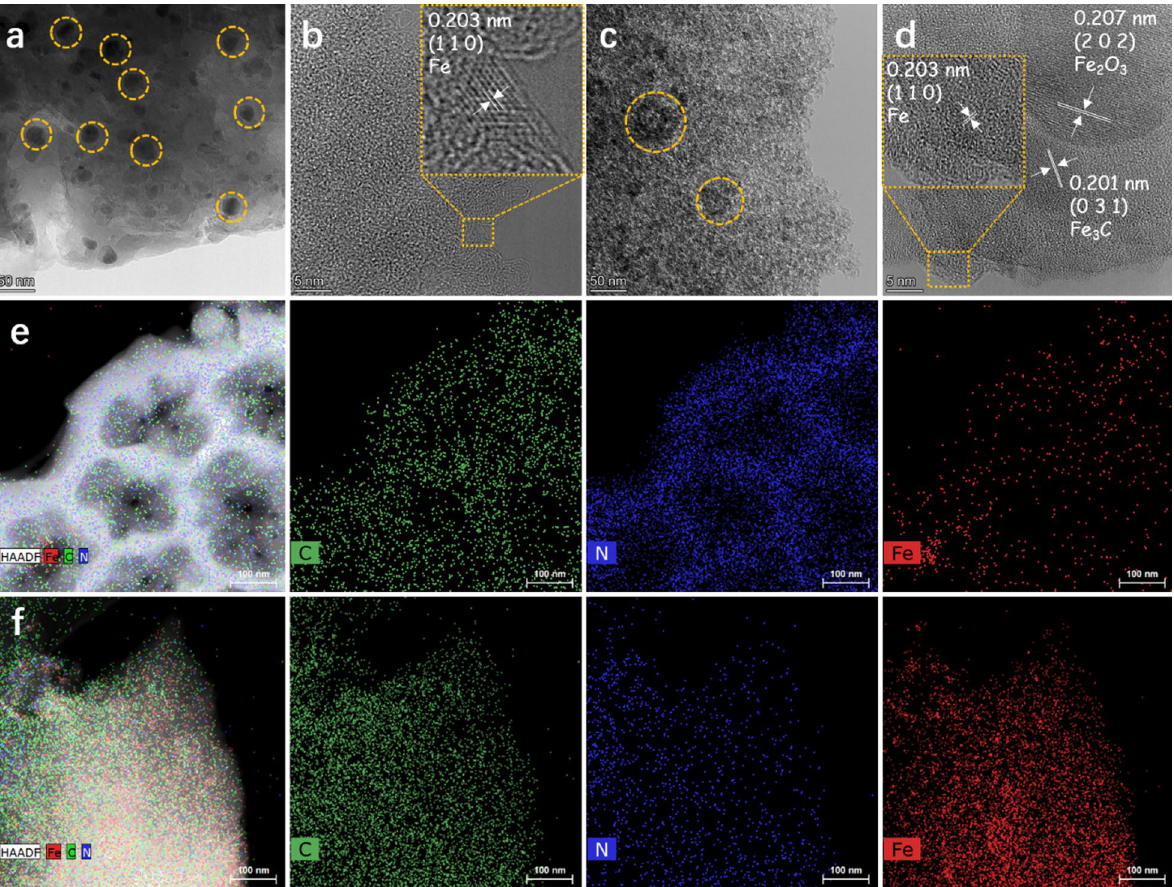
Fig. 1 TEM images of ( a , b ) SFB900-0 and ( c , d ) SFB900-3 samples at 50 nm and 5 nm. HAADF-STEM image and corresponding EDS mapping profiles for C, N and Fe in ( e ) SFB900-0 and ( f ) SFB900-3